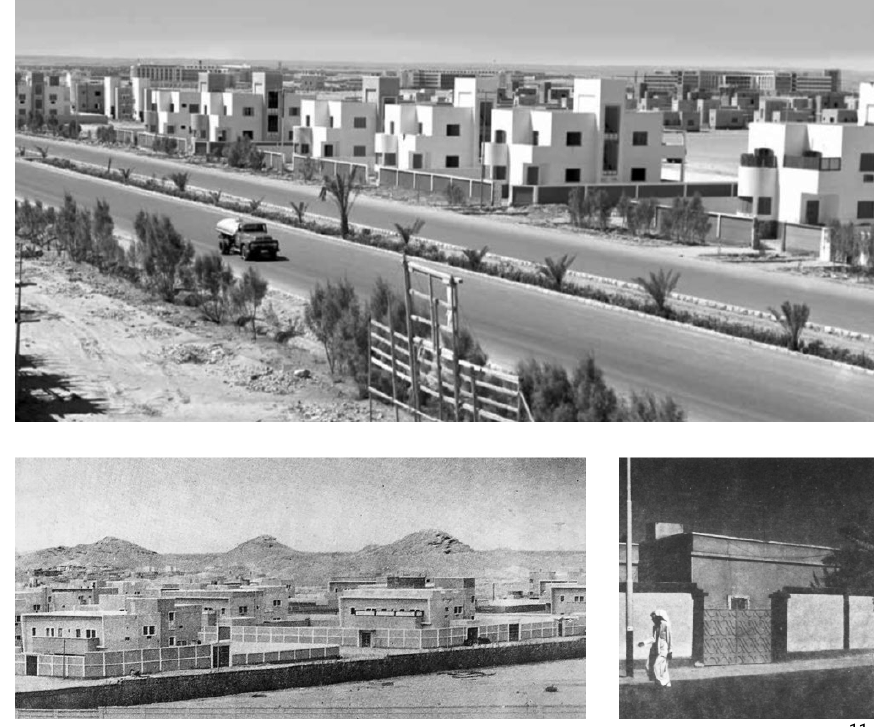
Fig. 11 Three different types of housing built by the government in Al- Malaz. Source: Riyadh during king Saud